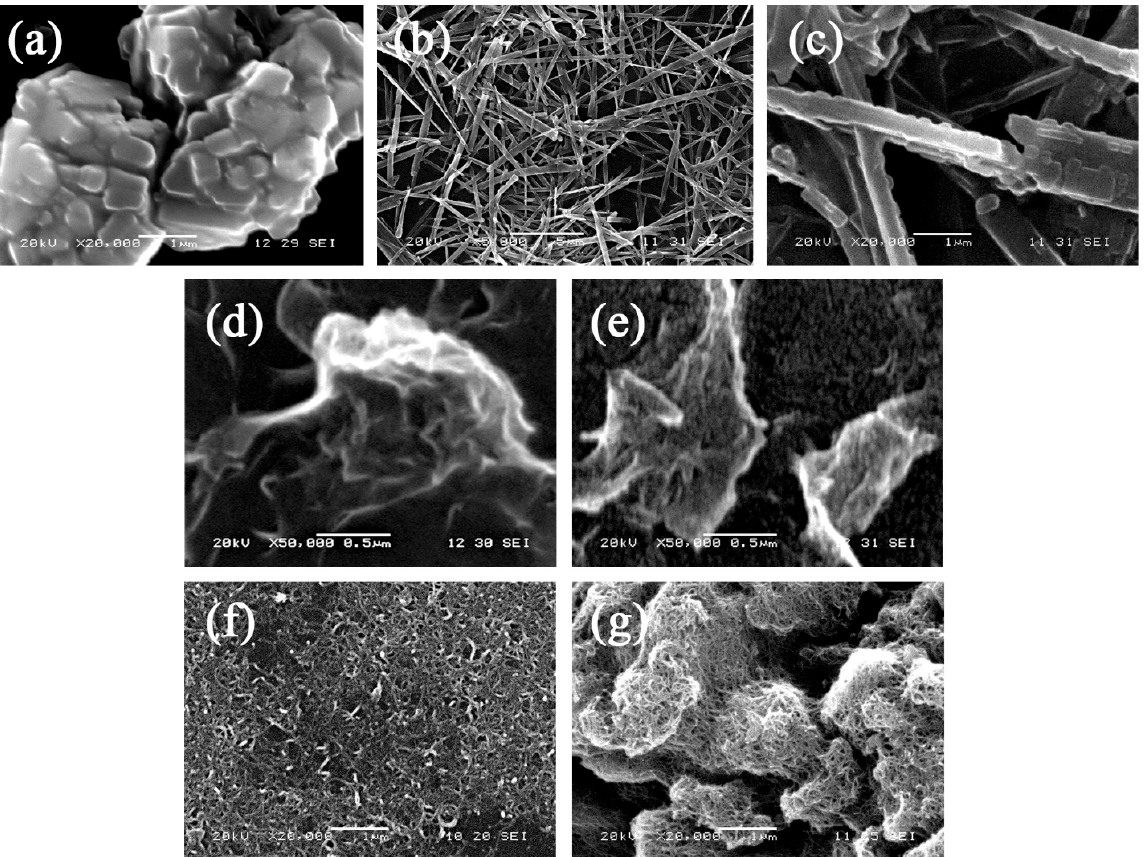
Figure 3. SEM images of ( a ) buckminsterfullerene (C 60 ) spin coated on silica substrate, ( b ) and ( c ) C 60 sprayed on silica substrate ( d ) rGO, ( e ) C 60 -g-rGO, ( f ) CNT, ( g ) C 60 -g-CNT.